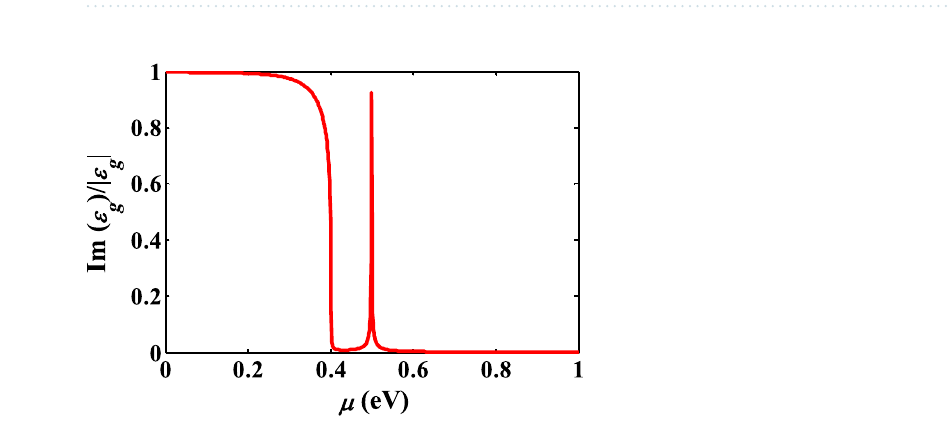
ε g (cid:31) as a function of chemical potential at of 1550 nm. (cid:31) (cid:31)